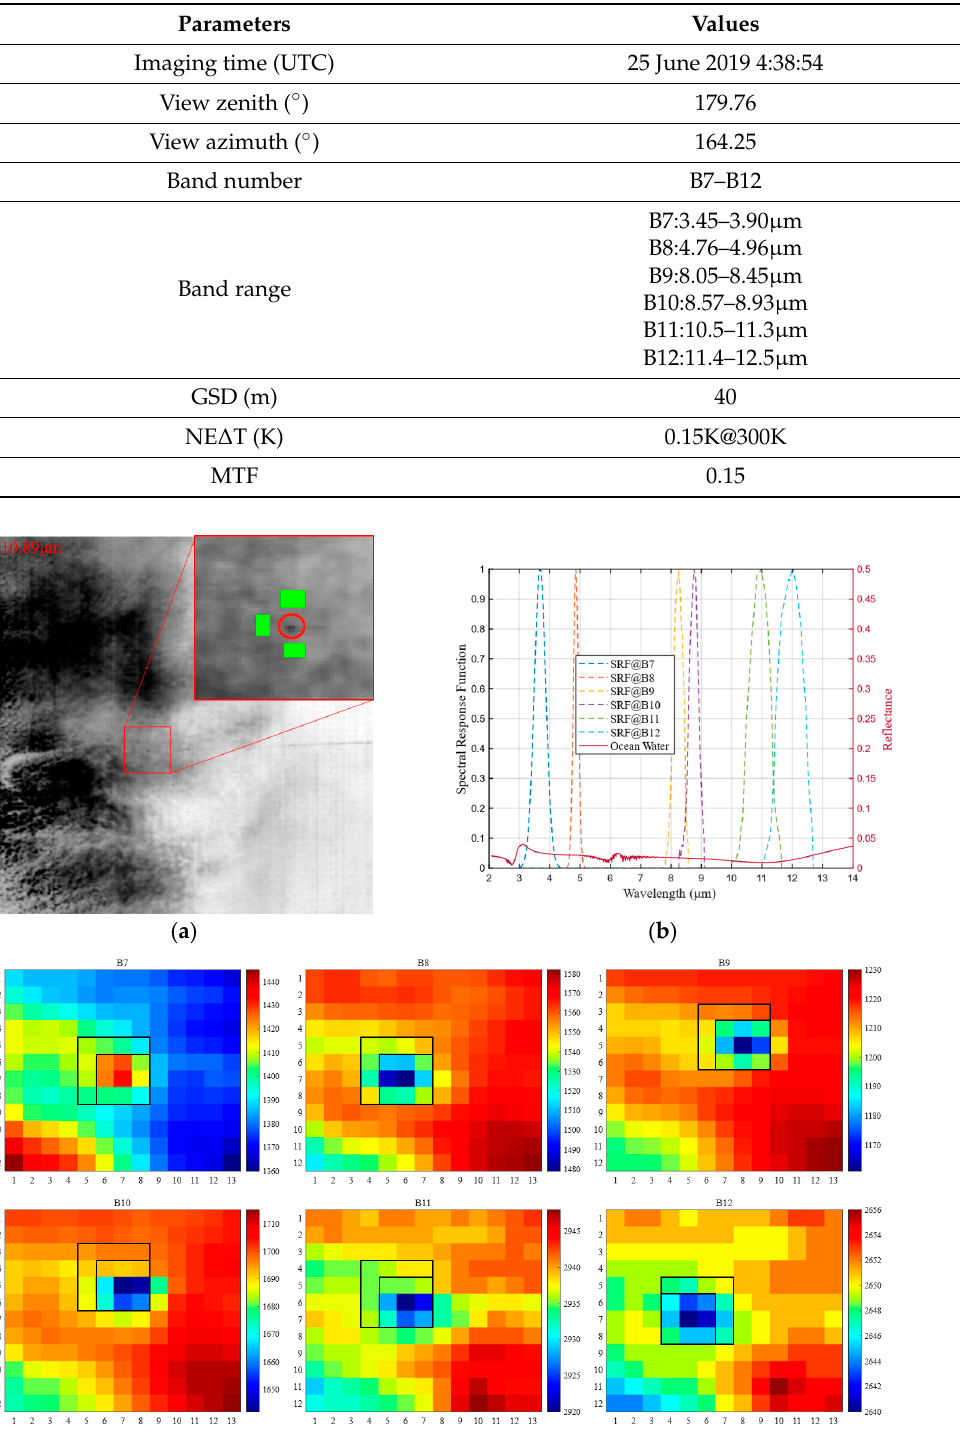
Table 1. Imaging information and instrument performance parameters of GF-5 VIMS.